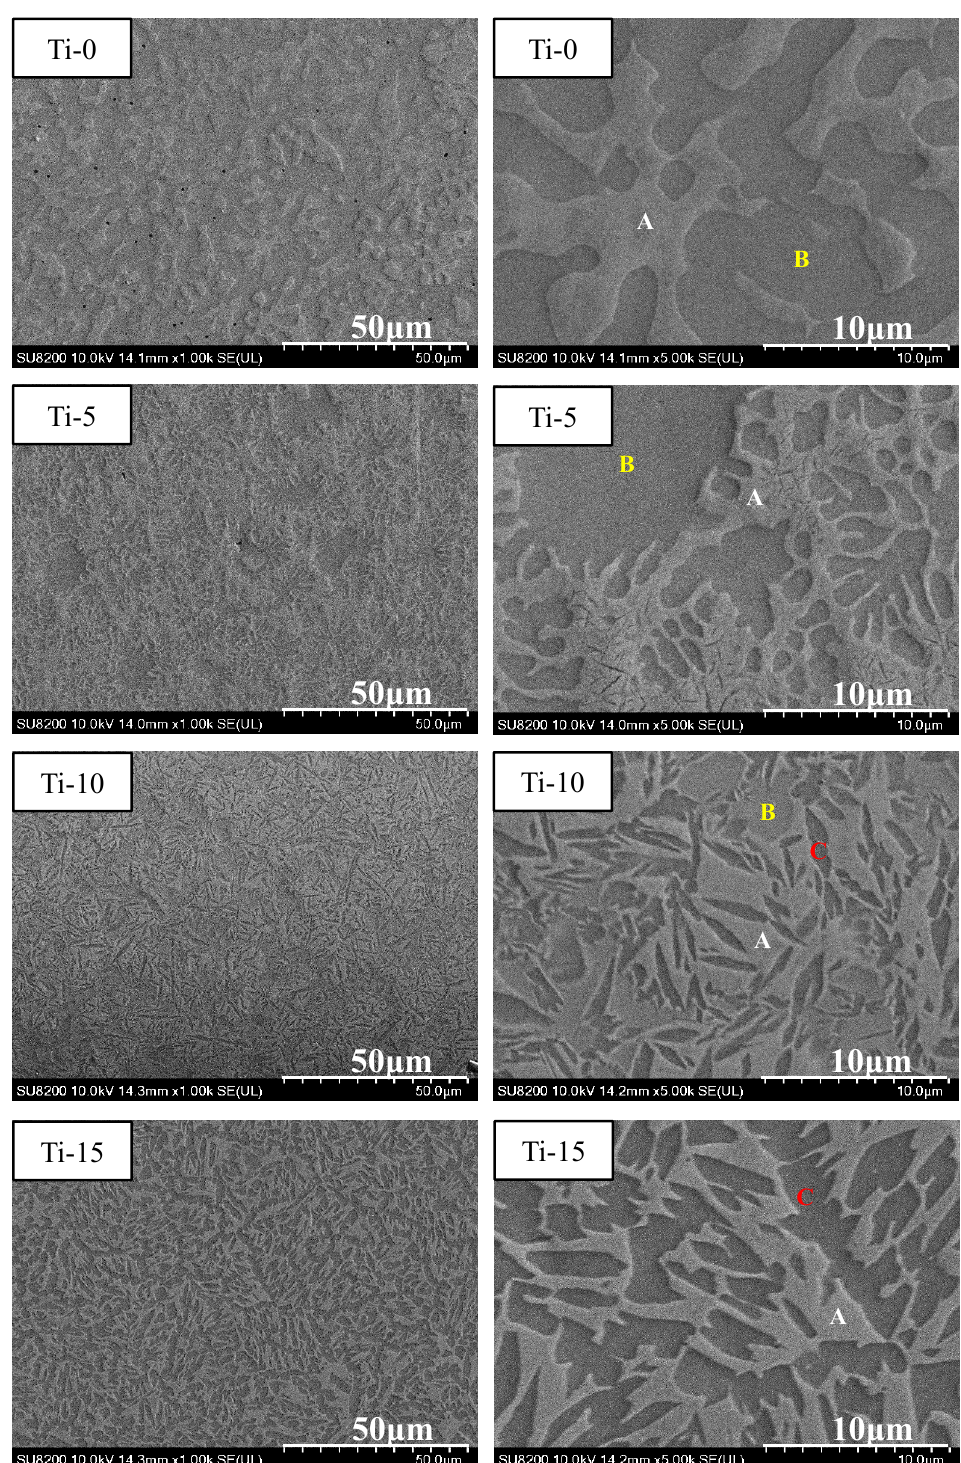
Figure 3. SEM images of the Al 50 (CrMnV) 50-x Ti x (x = 0, 5, 10, 15) alloys (A: BCC-1; B: BCC-2; C: FCC).